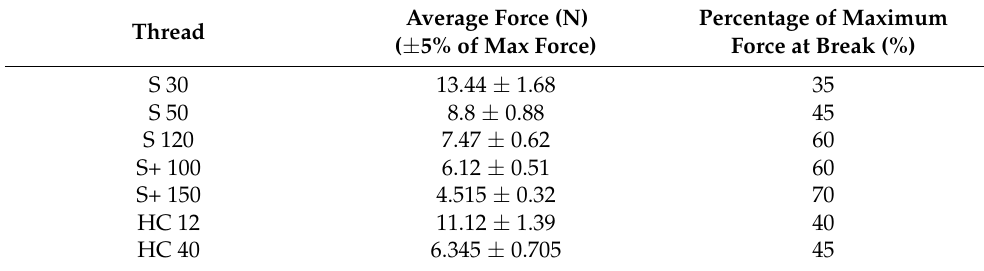
Table 4. Tension-exerting force causing permanent damage per